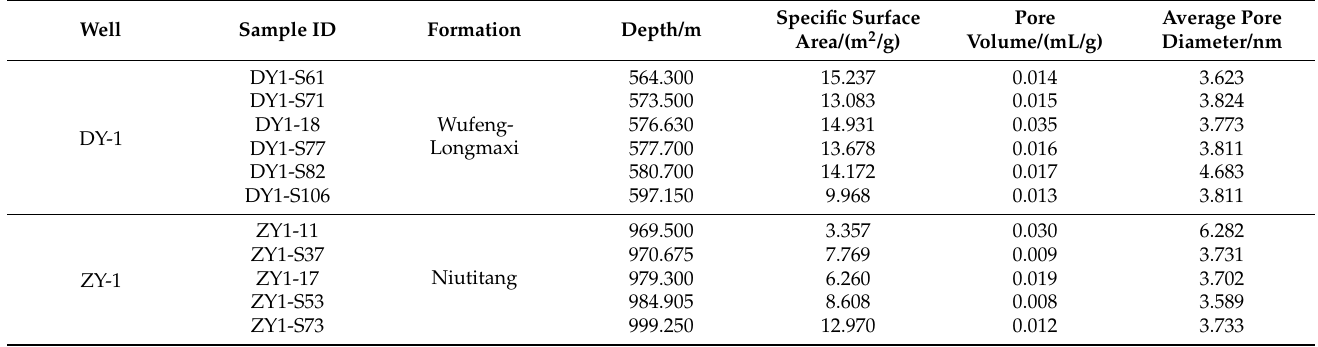
Table 6. Pore structure parameters of shale in the Wufeng-Longmaxi and Niutitang Formations in northern Guizhou Province based on the N 2 adsorption method.